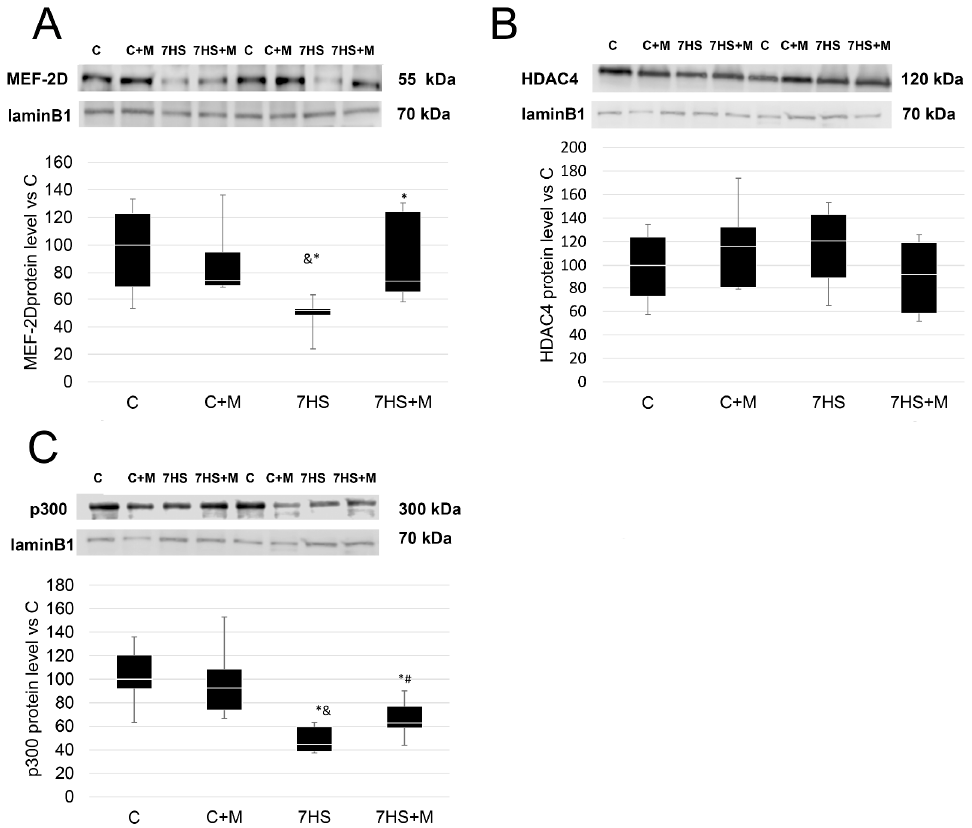
Figure 6. Western blot of MEF-2D ( A ), HDAC4 ( B ) and HAT p300 ( C ) nuclear protein levels in control group (C), control group with metformin (C+M), 7-day hindlimb-suspended group (7HS), and 7-day hindlimb-suspended group with metformin (7HS+M). Data are shown as % of the control group and median of the C group has been arbitrarily set to 100%. *—significant difference from the control group. &—significant difference from C+M group. #—significant difference from 7HS group ( p < 0.05). Box plots show 25–75 percentiles and median values and the whiskers represent the minimum and the maximum; n = 8/group.